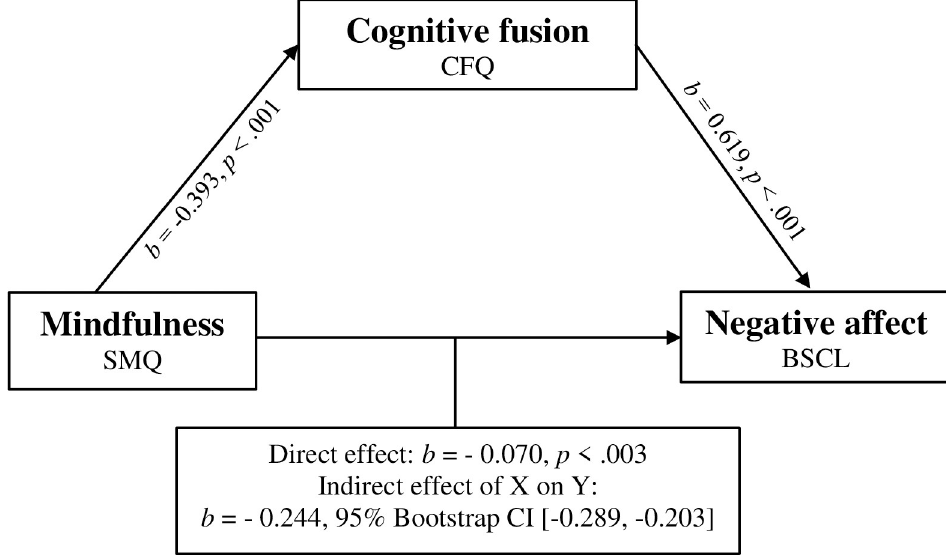
Fig 1. Model 4 Mediation model of mindfulness, cognitive fusion and negative affect. Model 4 mediation model of mindfulness, cognitive fusion and negative affect. SMQ: Southampton Mindfulness Questionnaire; CFQ: Cognitive fusion questionnaire; BSCL: Brief Symptom Checklist. Model controlled for